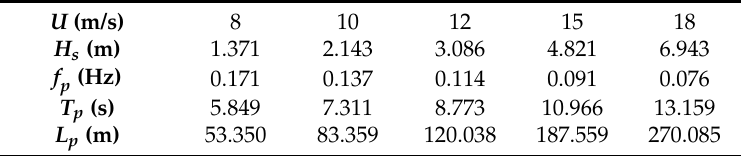
Table 1. Characteristics of waves at the spectral